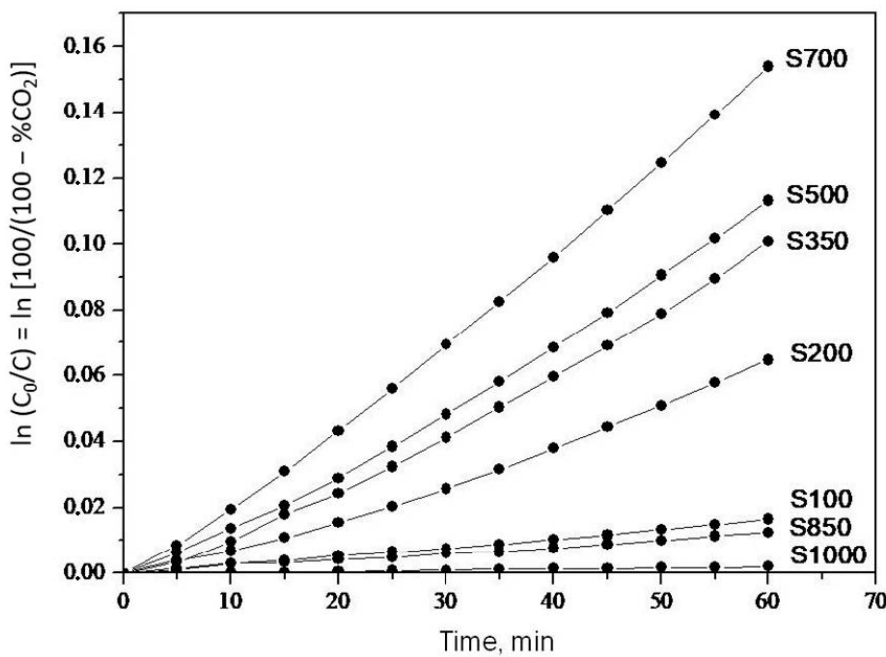
Figure 1. Langmuir–Hinshelwood kinetic plots (see eq. 3) based on CO 2 produced from the pho ‐ tooxidation of hexane (600 ppm) sensitized by synthetic TiO 2 samples (calcined from 100 °C, S100, to 1000 °C, S1000). The experimental error is ≤ 10%.